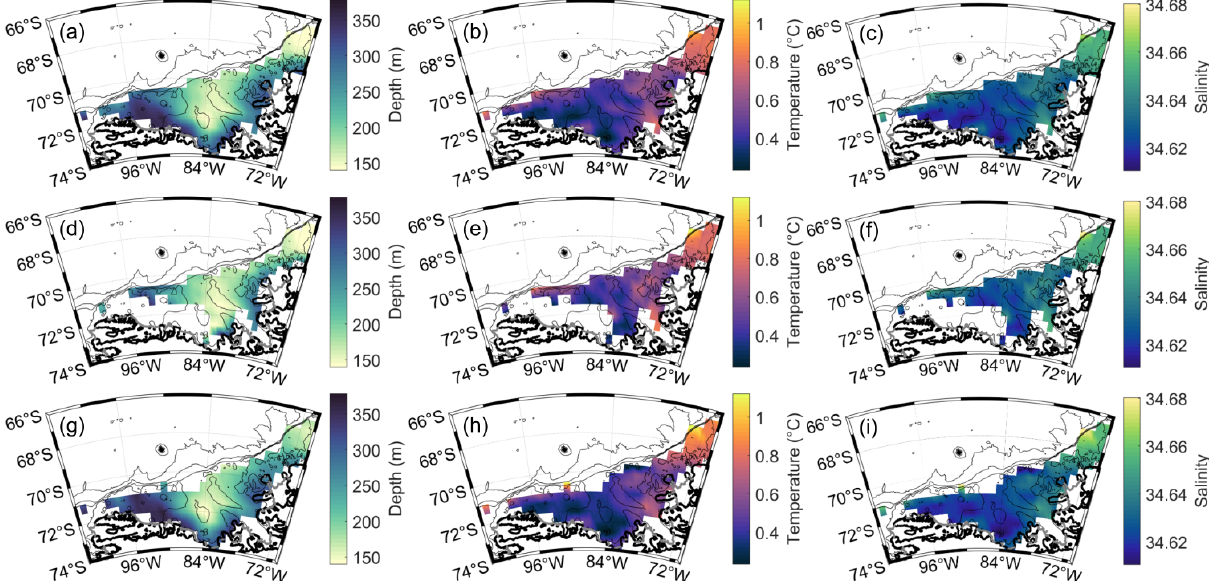
Figure A3. The distribution of properties on the transitional potential density layer ( σ 0 = 27 . 65kgm − 3 ), divided into (a–c) median, (d–f) winter (April–September), and (g–i) summer (October–March) months. (a, d, g) Depth of the density layer (meters), (b, e, h) potential temperature (degrees Celsius), and (c, f, i) salinity are